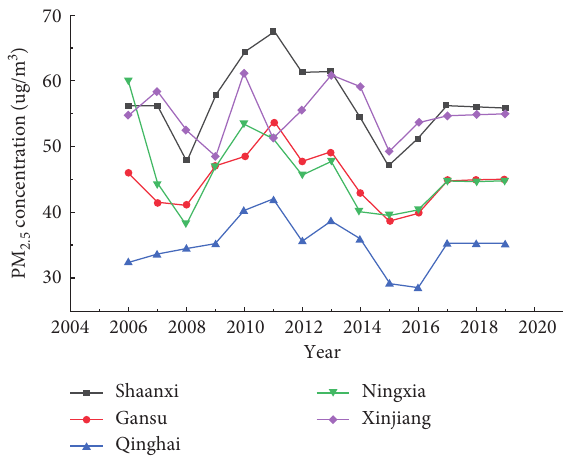
Figure 7: The PM 2.5 concentrations and prediction values of Northwest